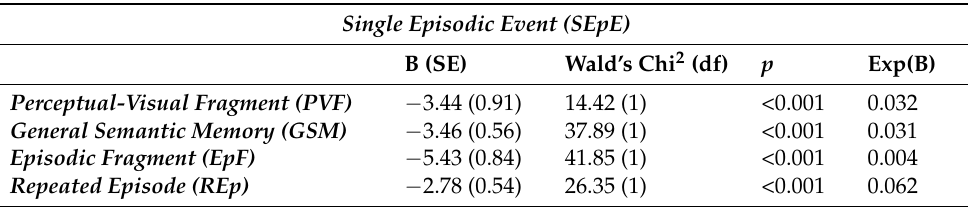
Table 2. Predictive effect of the perceptual-visual fragment, general semantic memory, episodic fragment, and repeated episode on Single Episodic Event (SEpE) (Epoch 2, n = 224). Single Episodic Event